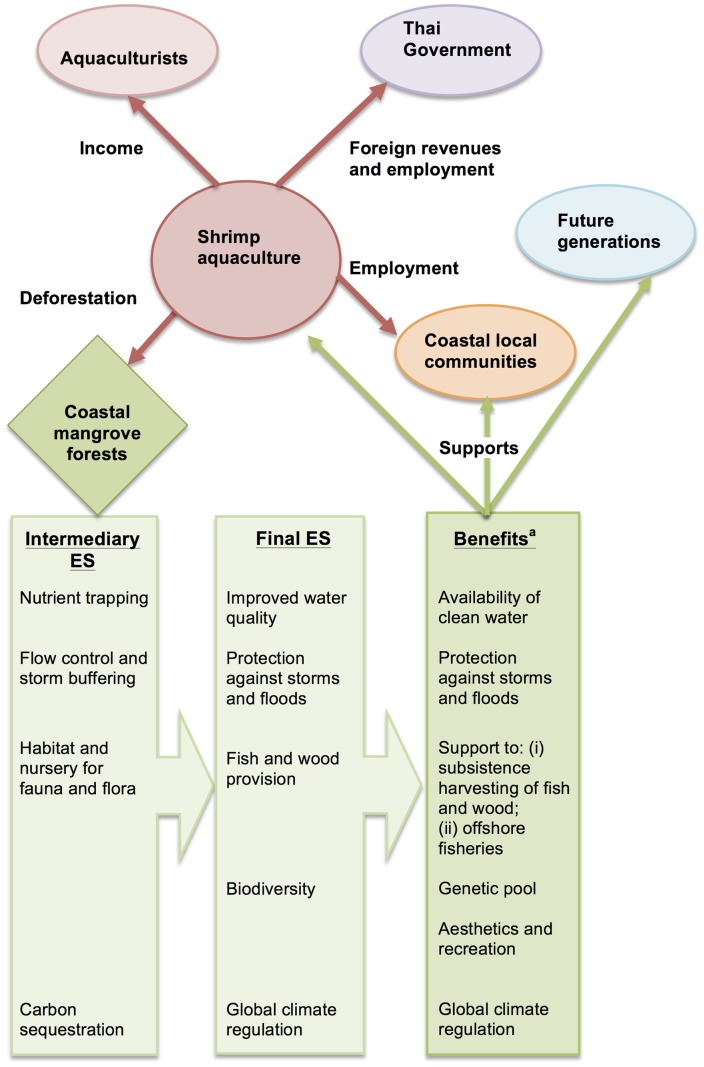
Aquaculture's main impacts on the environment, the economy and livelihoods and related user-conflicts.ES = Ecosystem Services. a Benefits should be distinguished from final ES since they are often a product of final ES and human inputs (e.g. fishing gear) and economic valuation of ecosystem should apply to ecosystem benefits only [13], [54], [55]. Figure based on information from [40] and [8], relying on the ecosystem services classification by [13], [55].